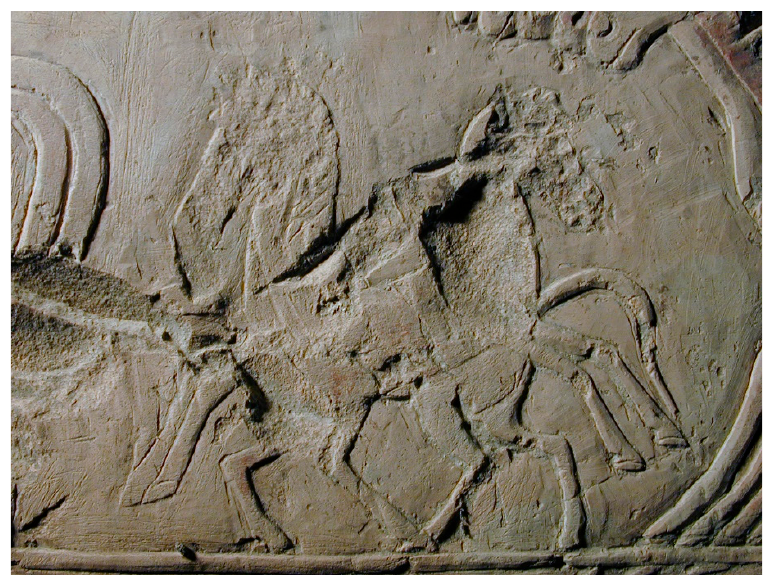
Figure 18. Two foals playing in the tomb of Amenemhat, TT123. Photo: Dimitri Laboury.